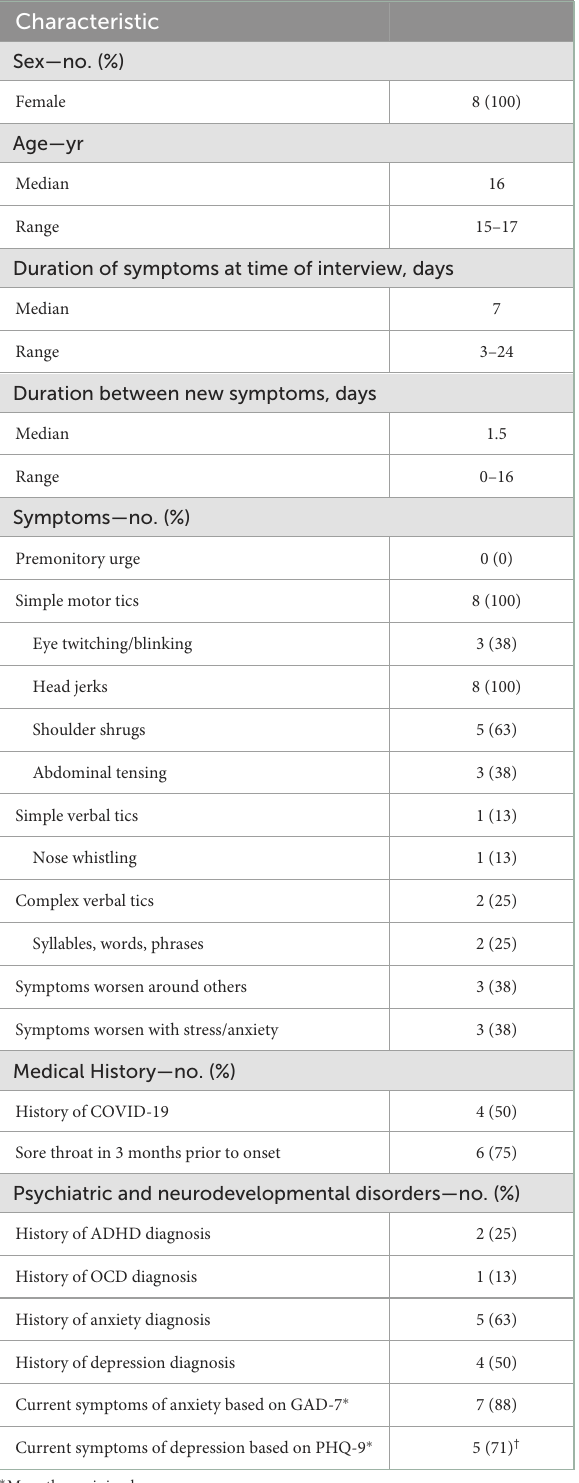
TABLE 1 Demographic characteristics, symptoms, and medical history of persons experiencing functional tic-like behaviors, Minnesota, September–November 2021.